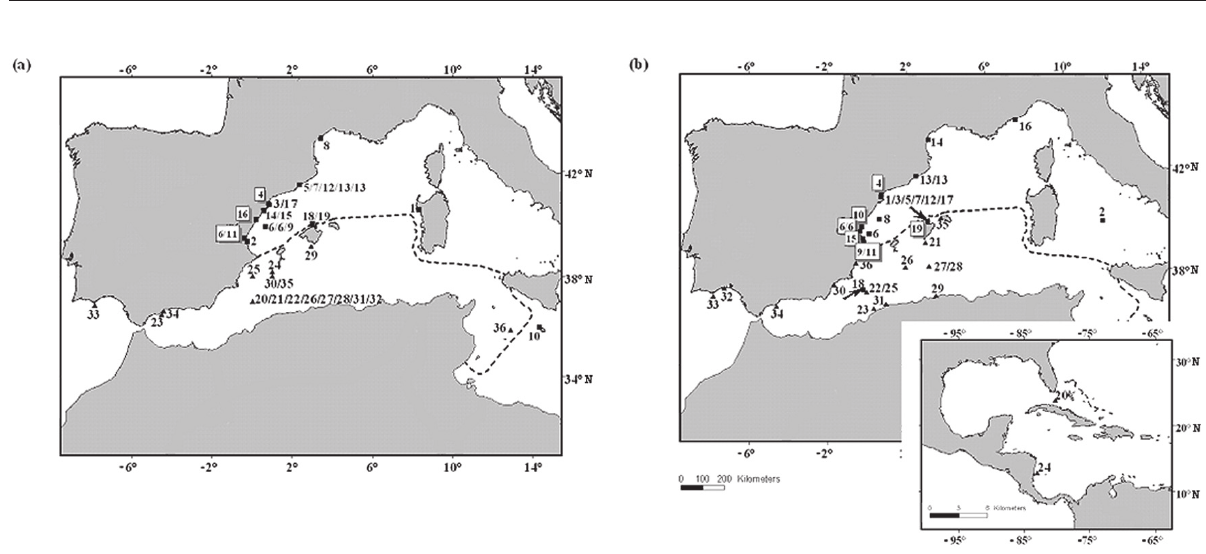
Fig . 3. – Locations of (a) release and (b) recapture of the northern tagged (squares) and southern tagged (triangles) turtles. Numbers identify individual turtles as in Table 1. Table 2. – Expected and observed frequency of northern-tagged and southern-tagged loggerhead sea turtles recaptured in the northern and southern regions of the western Mediterranean and results of the Chi-square tests. Northern-tagged